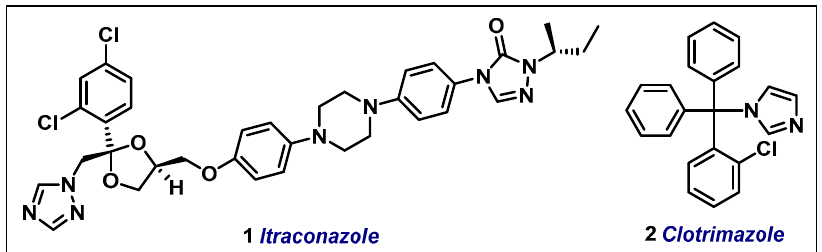
Figure 1. Chemical structures of clotrimazole and itraconazole.